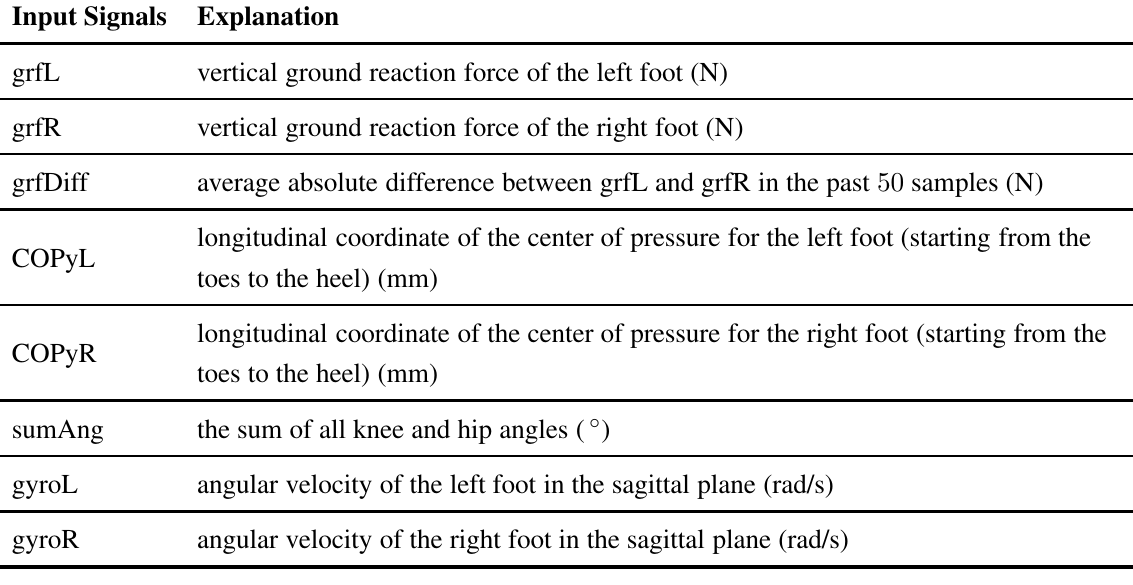
Table 1. Chosen input signals for the transition and phase detection algorithm. The left column lists signal tags and the right column the corresponding